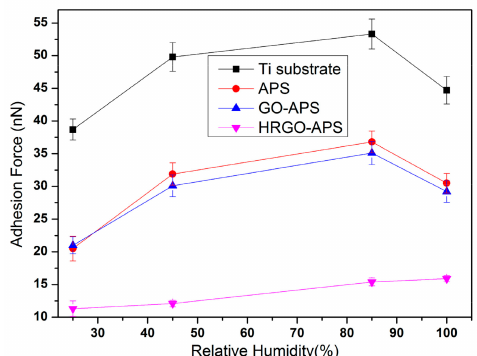
Figure 14. Variation of adhesion forces of deposited Ti substrate and prepared coatings under various RHs (Applied Load: 70 nN).